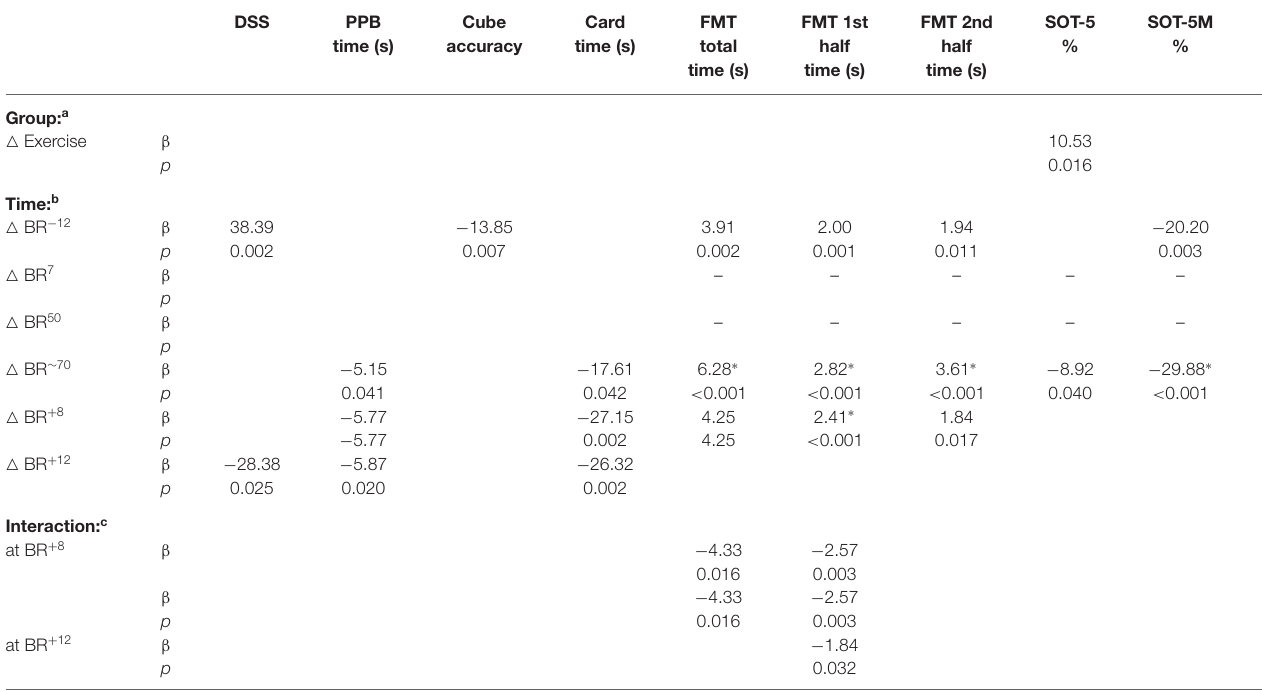
TABLE 3 | Interaction effects between bed rest with and without exercise countermeasure on cognitive and sensorimotor